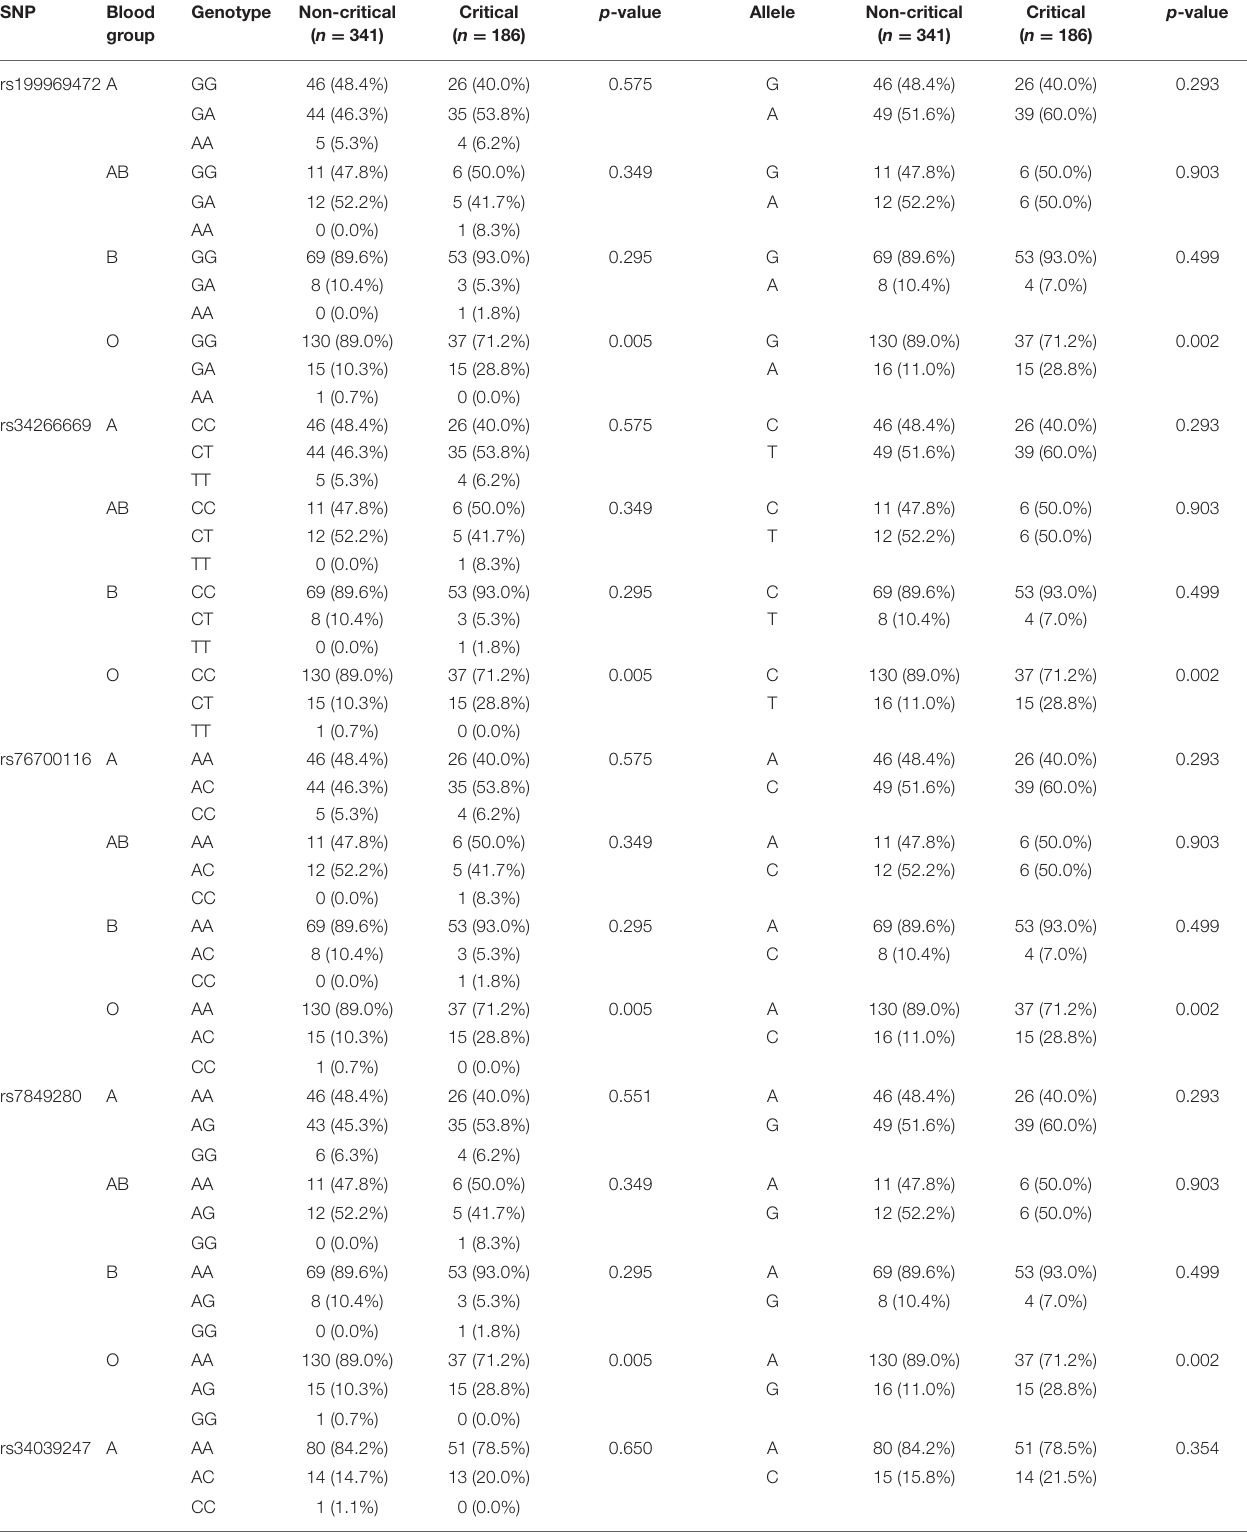
p -value Allele Non-critical